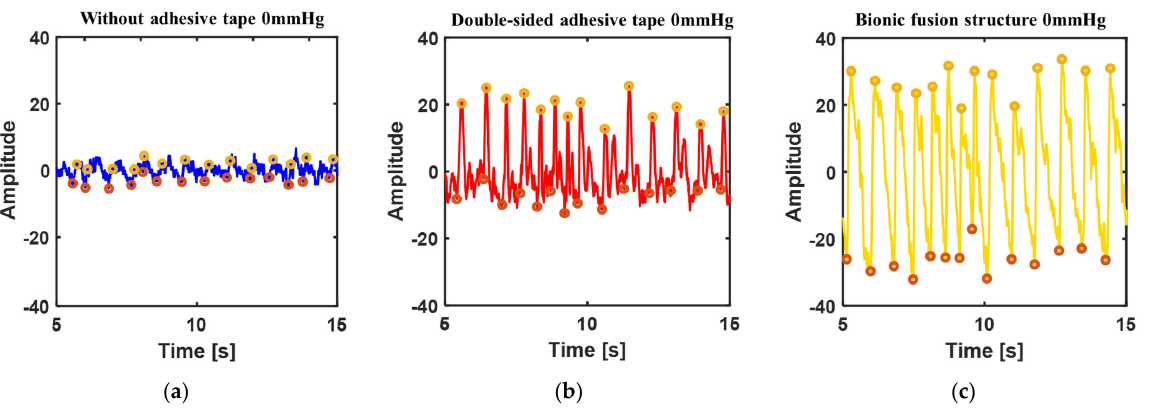
Figure 7. Comparison of pulse waveform under three adhesion conditions at 0 mmHg pressure: ( a ) Direct measurement without adhesive; ( b ) With 3M strong double-sided adhesive; ( c ) With the biomimetic fusion structure adhesion.